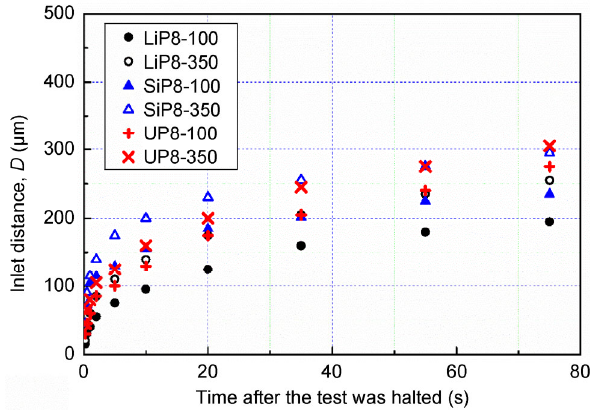
Fig. 8 Evolution of inlet distance D with time after the test was